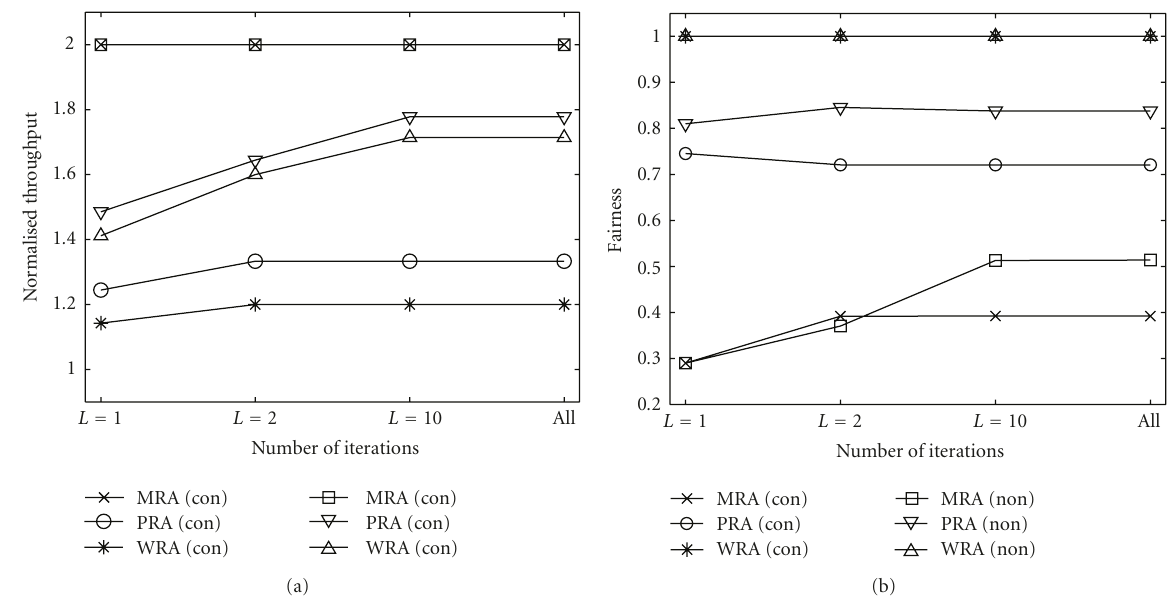
Figure 6: Throughput and fairness results for the experimented sessions: (a) throughput and (b)